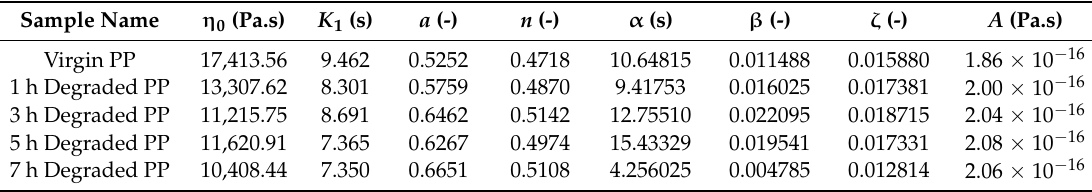
Table 2. Generalized Newtonian model parameters for T = 180 ◦ C, ψ = 8.